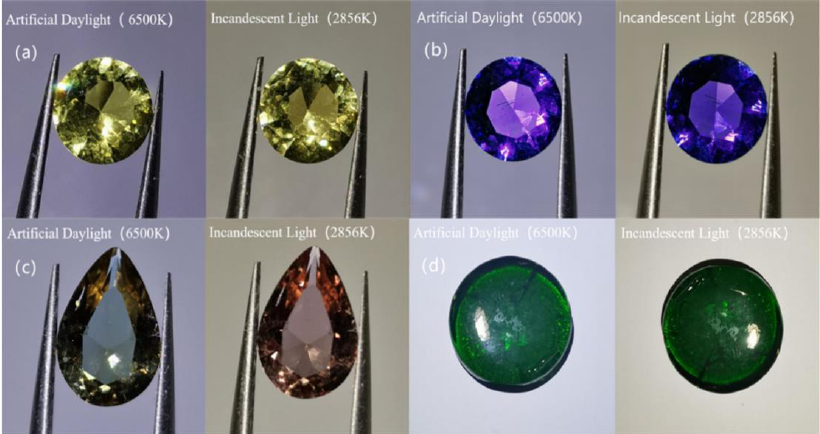
Figure 3. Samples in artificial daylight and incandescent lamp: ( a ) sample 1; ( b ) sample 2; ( c ) sample 3; and ( d ) sample 4.